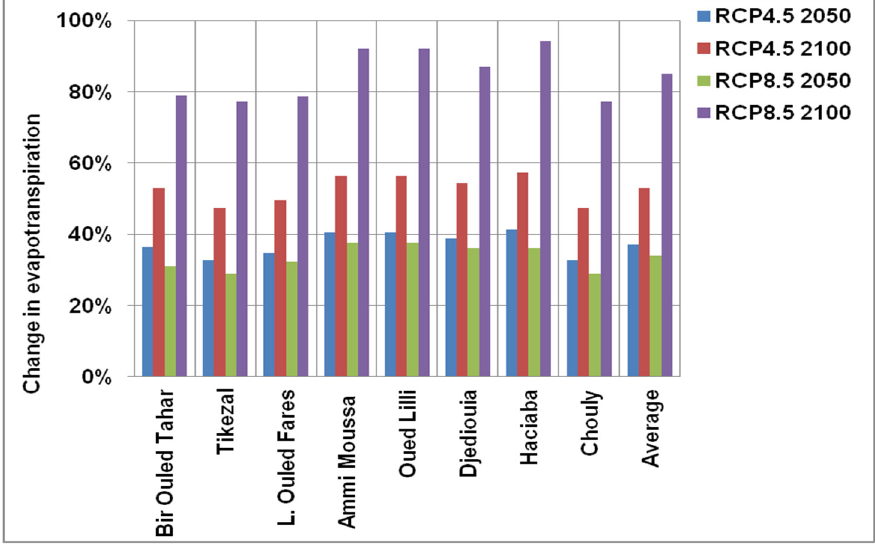
Figure 3. Changes in evapotranspiration under two scenarios (RCP4.5 and RCP8.5). Table 5. Annual precipitation mean changes in the CMT basins from the baseline period